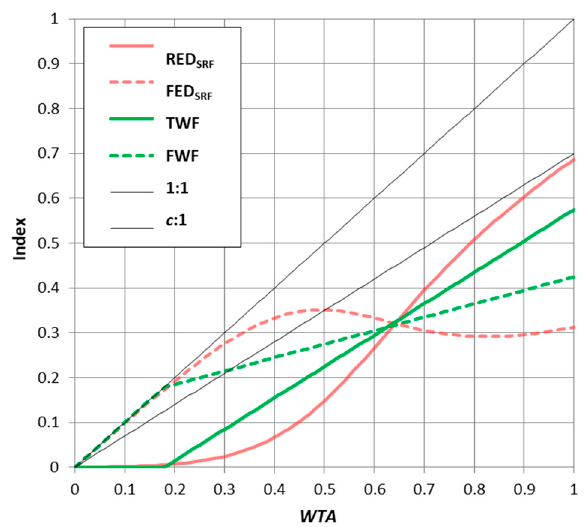
Figure 4. Water impact indices for the SRF irrigation-dominated best-fit special case where T ‘ = 0.125 and c = 0.7. Note the similarity between RED SRF, in red, and TWF, in green. RED SRF and TWF are approximately equal below WTA = 0.20 and at WTA = 0.63. BWF is coincident with the c :1 line, and is somewhat higher than RED and TWF.